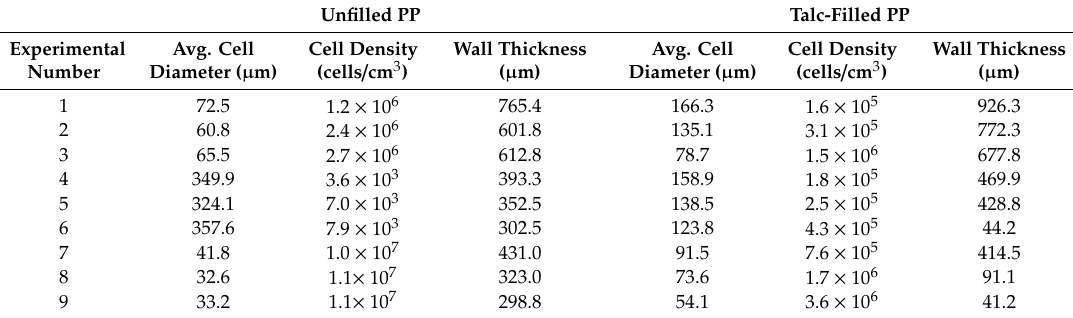
Table 4. Microstructure